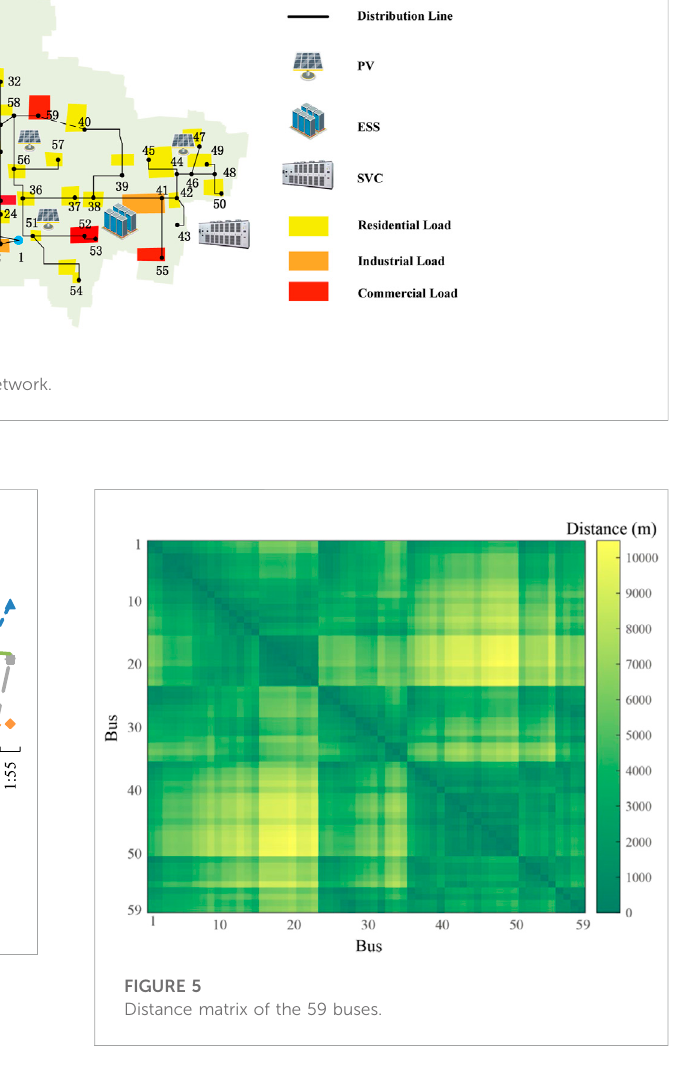
the network recon fi guration scheme and the red dashed line denotes the disconnected lines. As shown in Figure 6, the entire network was divided into two microgrids, while only 45 buses and 43 lines were connected to the grid.